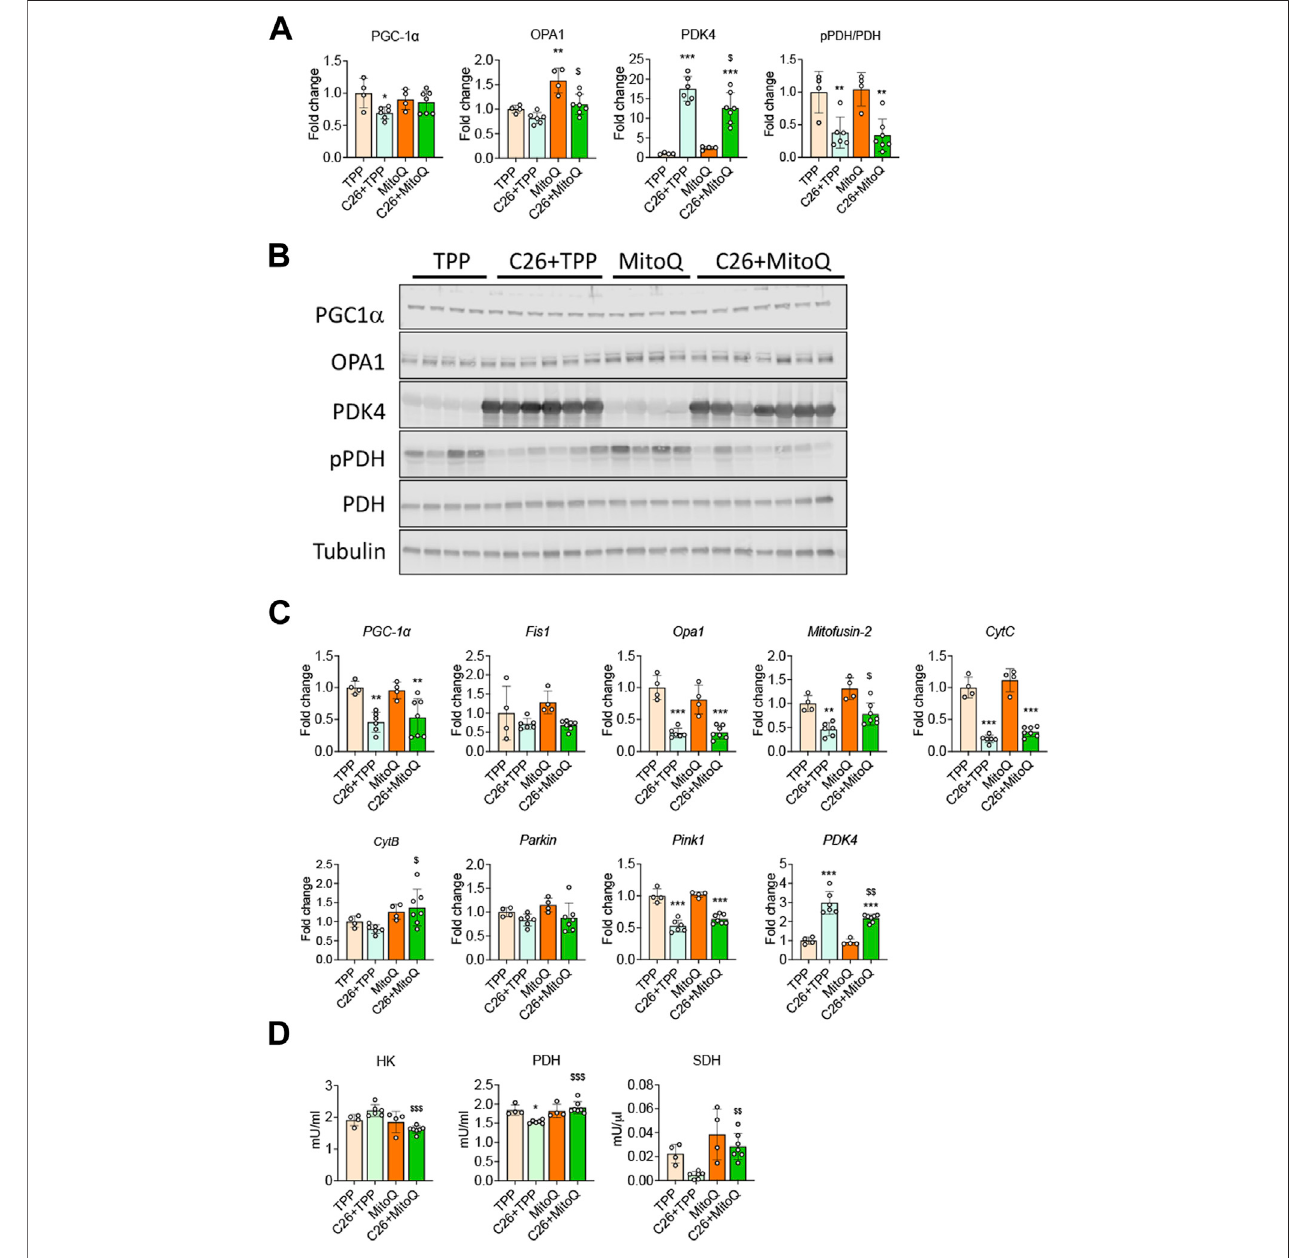
FIGURE 4 | MitoQ affects mitochondrial homeostasis and metabolism. (A,B) Quanti fi cation and representative Western blotting for PGC1 α , OPA1, PDK4, phospho-PDH (pPDH), PDH, expressed as fold change vs. TPP. Tubulin was used as loading control. (C) Gene expression levels for PGC1 α , Opa1, Fis1, Mitofusion-2, CytC, CytB, Parkin, Pink1 and Pdk4 in the gastrocnemius muscle. Gene expression was normalized to TBP levels and expressed as fold change vs. TPP. (D) Muscle enzymaticactivitiesofhexokinase(HK),pyruvatedehydrogenase(PDH)andsuccinatedehydrogenase(SDH)intheskeletalmusclewereexpressedinmilliunits/mL (mU/mL) or milliunits/µL (mU/ μ L). Data are expressed as means ± SD. Statistical signi fi cance was evaluated by two-way analysis of variance, and signi fi cant differences (at least p < 0.05) were reported as: * p < 0.5 ** p < 0.01 *** p < 0.001 vs. TPP; $ p < 0.05, $$ p < 0.01, $$$ p < 0.001 vs. C26 + TPP.